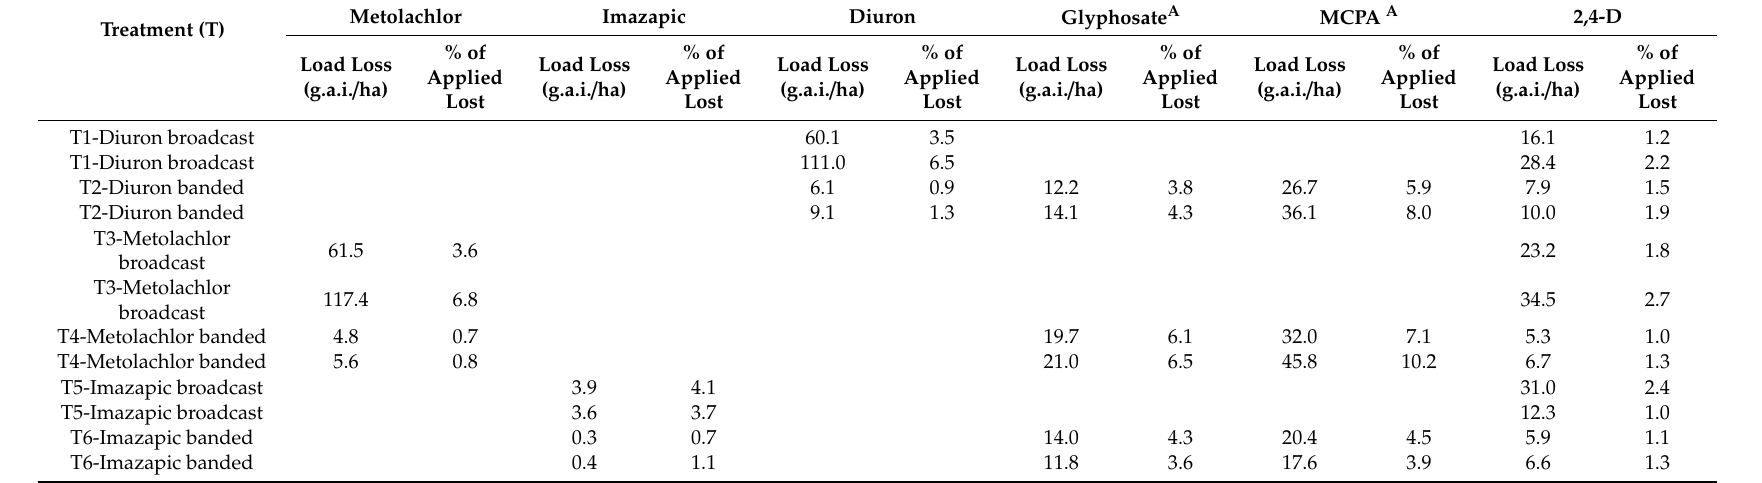
Table 4. Herbicide runo ff load data (g.a.i. / ha, and % of applied herbicide lost) for 12 monitored flumes across six treatments. Treatment (T)